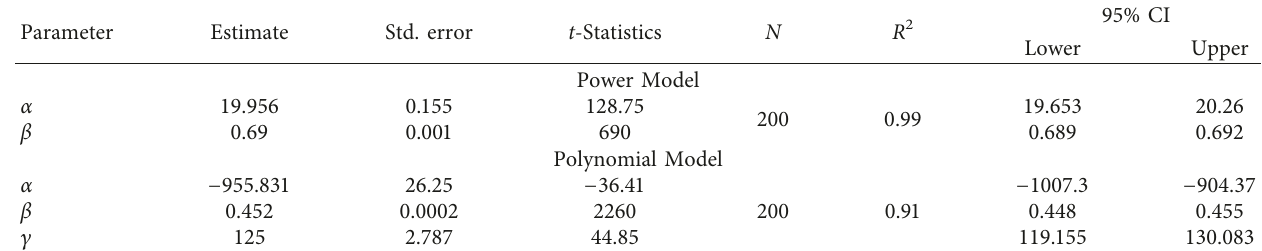
Table 3: Summary statistics of developed models.